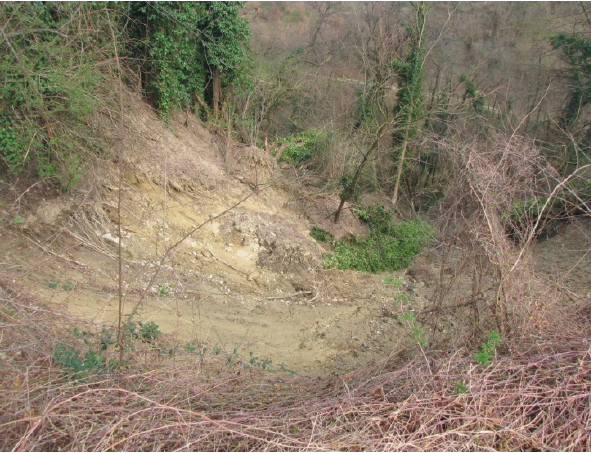
Figure 3. Stratigraphic section along the testsite slope [24].